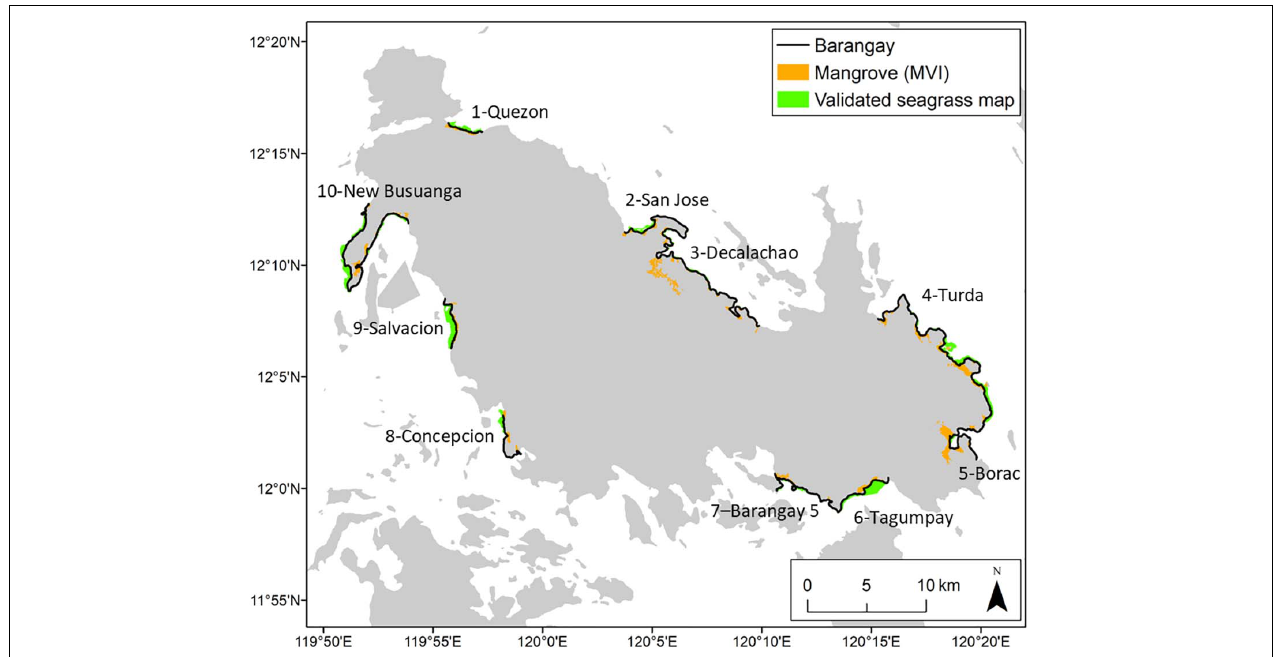
FIGURE 2 | Mangrove and seagrass coverage in Busuanga Island. Municipality of Busuanga: 1- Quezon, 10- New Busuanga, 9- Salvacion, 8- Concepcion; Municipality of Coron: 2- San Jose, 3- Decalachao, 4- Turda, 5- Borac, 6- Tagumpay, 7- Barangay 5.